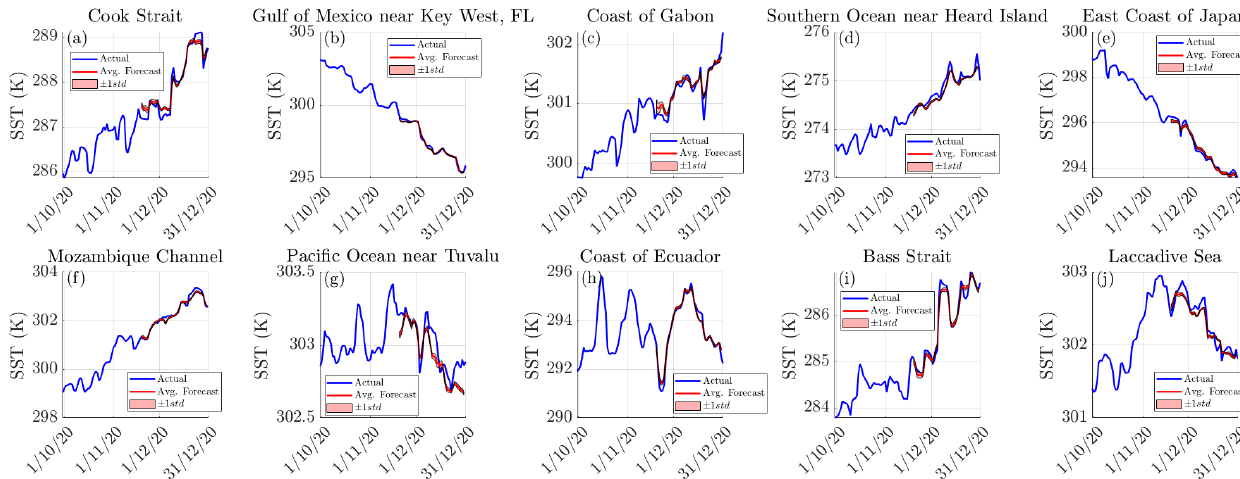
Figure 4. The 1d forecasts of the SST at various points in the ocean. The average forecasted SSTs and the true SSTs are represented by the red and blue lines, respectively. About the average there is a shaded outline representing ± 1 standard deviation in the forecast between models, although it is not entirely evident due to all of models ultimately predicting similar values.